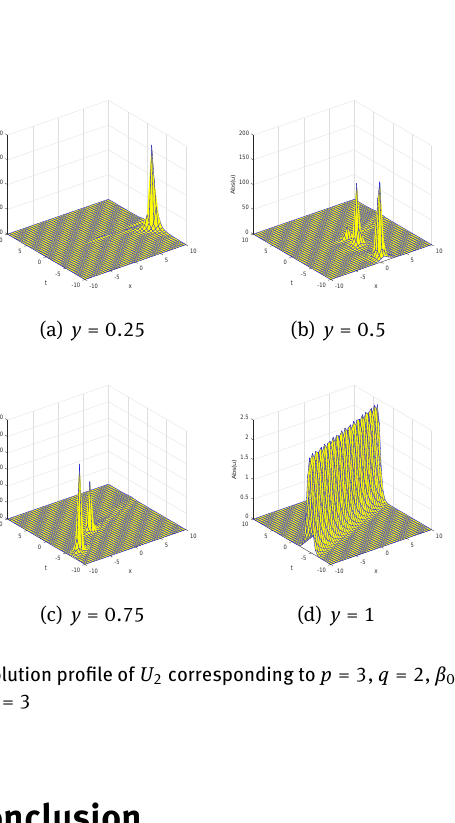
Fig. 2: Solution profile of U 1 corresponding to p = 3, q = 2, β 0 = 1 = β 1 and α = 3